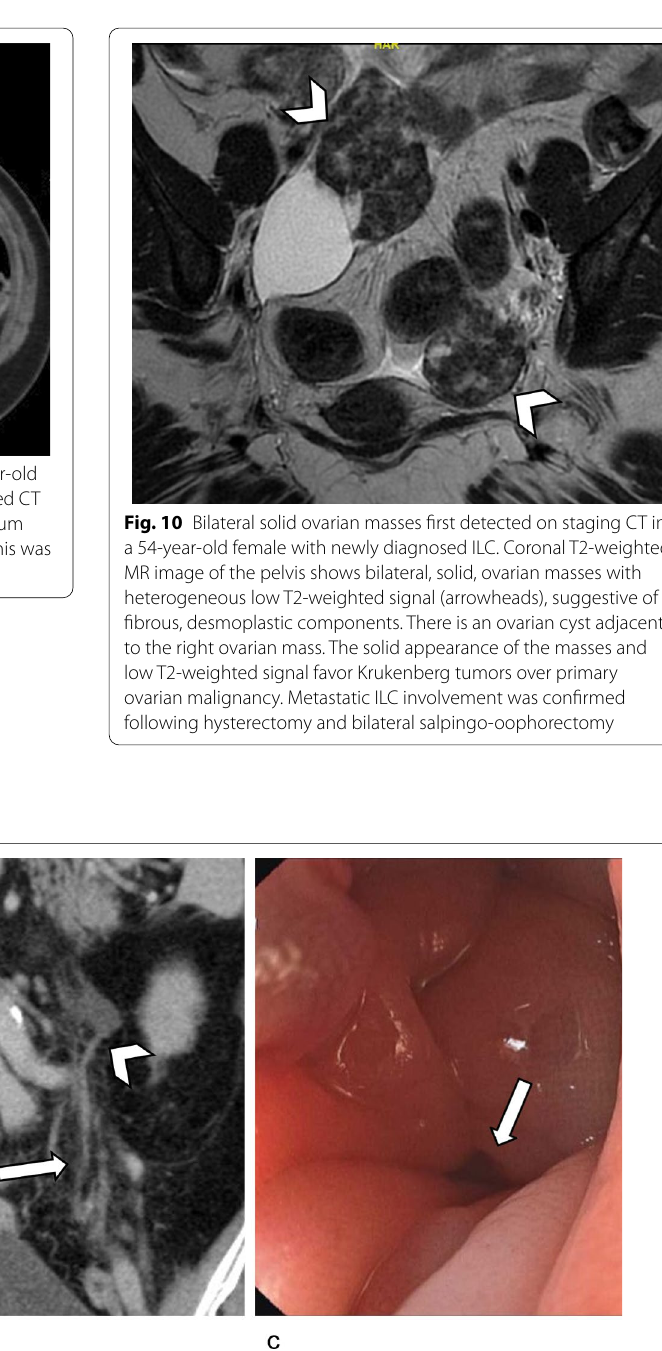
Fig. 9 Metastatic retroperitoneal involvement in an 80-year-old female, who presented with symptoms of bowel obstruction. She had declined surgical treatment for Stage 2B ILC a year earlier and was on letrozole. a Axial contrast-enhanced CT image shows a stricture of the descending colon, with a tethered, tapered appearance at its medial aspect (white arrow). The upstream transverse colon (*) is dilated. Left-sided hydronephrosis is also seen (black arrowhead). b Coronal contrast-enhanced CT image shows tiny metastatic nodules and stranding in the left side of the retroperitoneum (white arrow). The transition points of the left hydronephrosis (white arrowhead) and descending colon (not pictured) are within this nodular area. c Colonoscopy confirms a stricture of the descending colon (white arrow). The mucosa appeared normal on colonoscopy, and this was initially thought to represent a benign stricture. Subsequent open laparotomy confirmed disseminated metastatic disease in the retroperitoneum